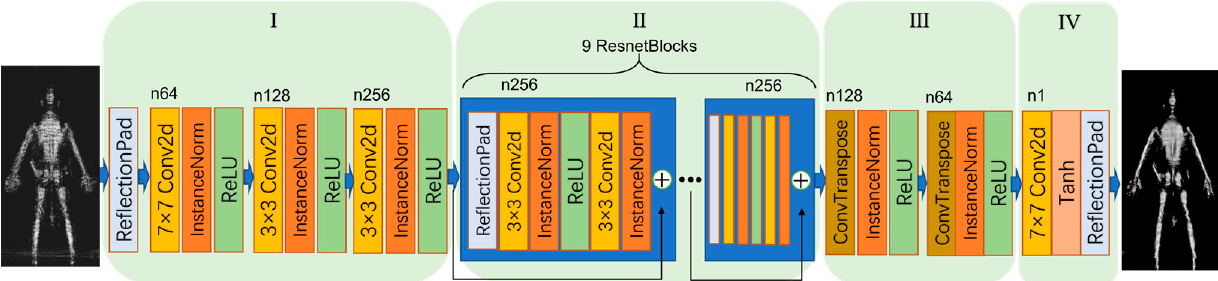
Figure 2. The schematic diagram of the proposed MMW deblurring Cycle GAN method.